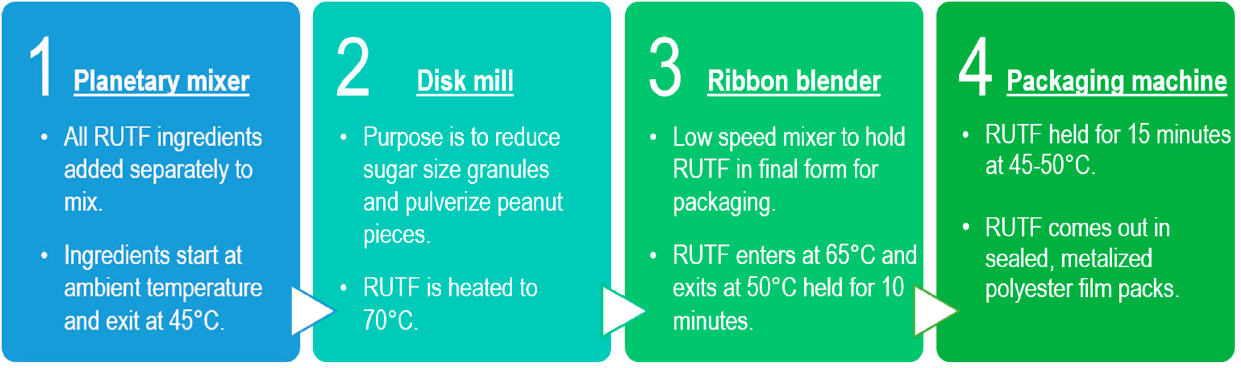
Figure 1. RUTF Manufacturing Process Stages. Samples were taken from stages 1 and 4 for the DHA stability tests. All ingredients are mixed in the planetary mixer before entering the disk mill, where the remaining larger pieces are pulverized to create a homogenous mixture. The ribbon blender mixes the RUTF at low speed and prepares it for packaging in stage 4. Temperatures range from 45–70 ◦ C between the end of the planetary mixer and the packaging machine